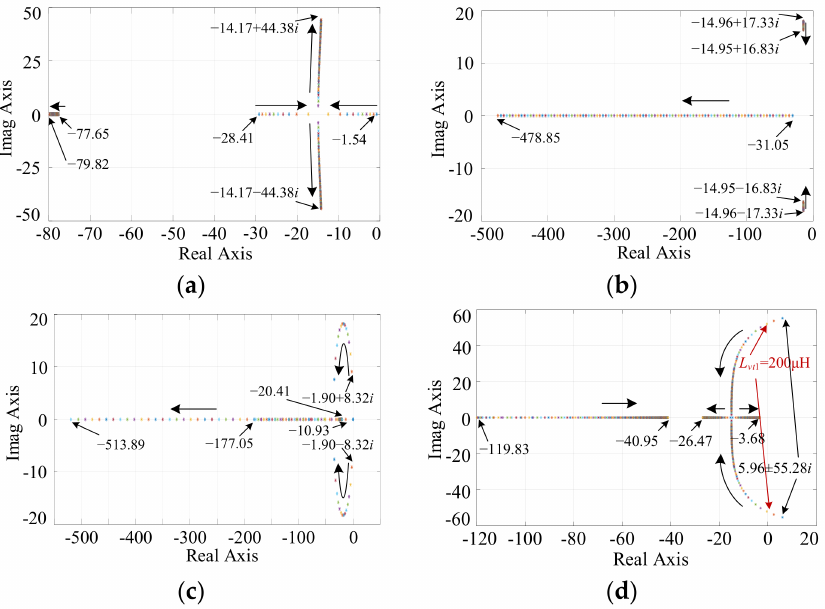
Figure 5. Root locus of DG inverter 1 under four cases. ( a ) Case 1; ( b ) Case 2; ( c ) Case 3; ( d ) Case